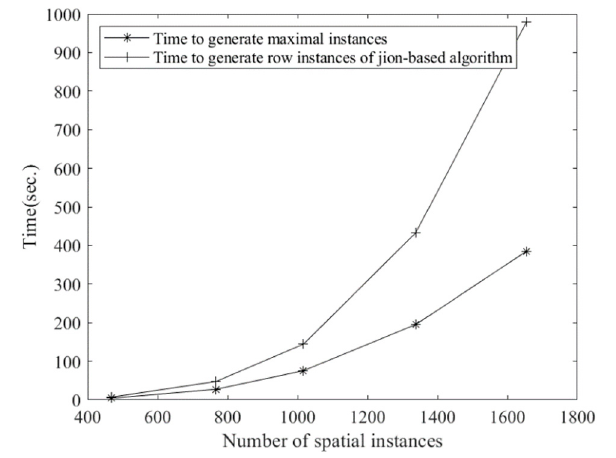
Figure 12. The effect of the number of spatial instances on the running time.